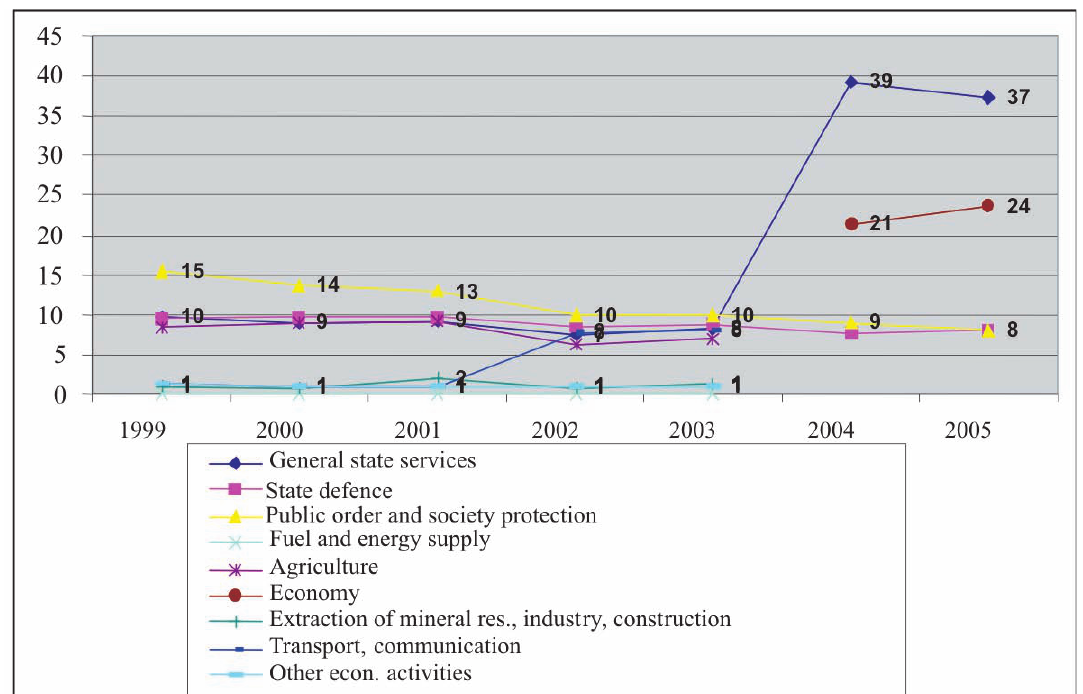
Fig 3. Lithuania’s state budget expenditure for fields dominated by men,